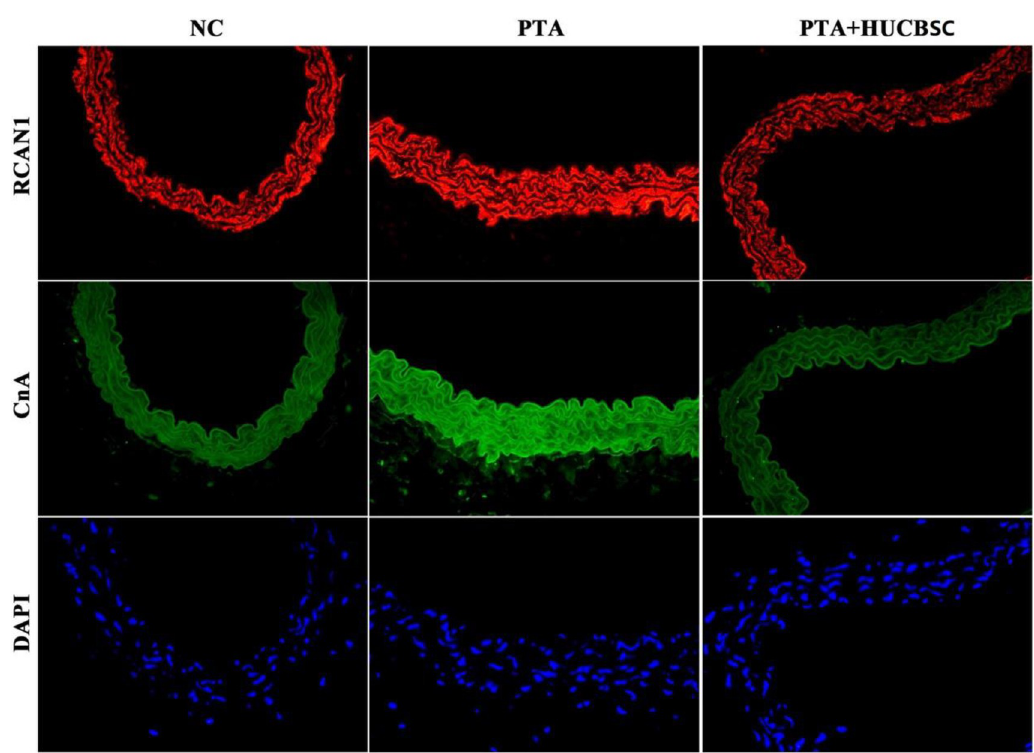
Fig 3. Comparison of RCAN1 and CNA expression in each group under fluorescence microscope (x400). First line: The expression of RCAN1in arterial wall under fluorescence electron microscope: the expression of RCAN1in the arterial tissues of the PTA+HUCBSC group was comparable to the normal group, and was lower than that of PTA group. Second line: The expression of CnA in arterial wall was observed under fluorescence electron microscope:the expression of CnA in the arterial tissues of the PTA+HUCBSC group was comparable to the normal group, and was lower than that of PTA group. Third line: DAPI staining of proliferating cells in the arterial wall under fluorescence electron microscope. https://doi.org/10.1371/journal.pone.0255162.g003 Distribution of HUCBSC in local arteries, distal arteries and liver after transplantation Pathological observation of the transplanted local arteries, distal arteries, and liver of the rab- bits treated for 4 weeks showed that the HUCBSCs were distributed in the transplanted local arteries, but not in the distal arteries and liver (Fig 4).